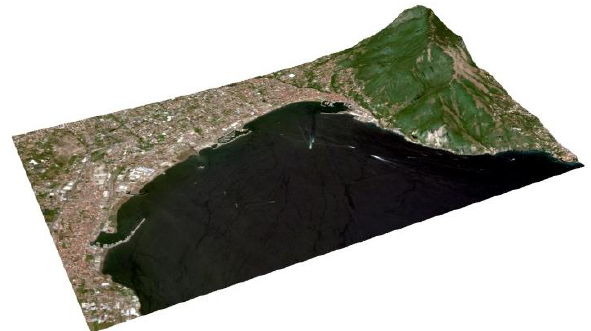
Figure 2. 3D photorealistic model of the study area resulting from drapery of the Sentinel-2 RGB true colour composition on the